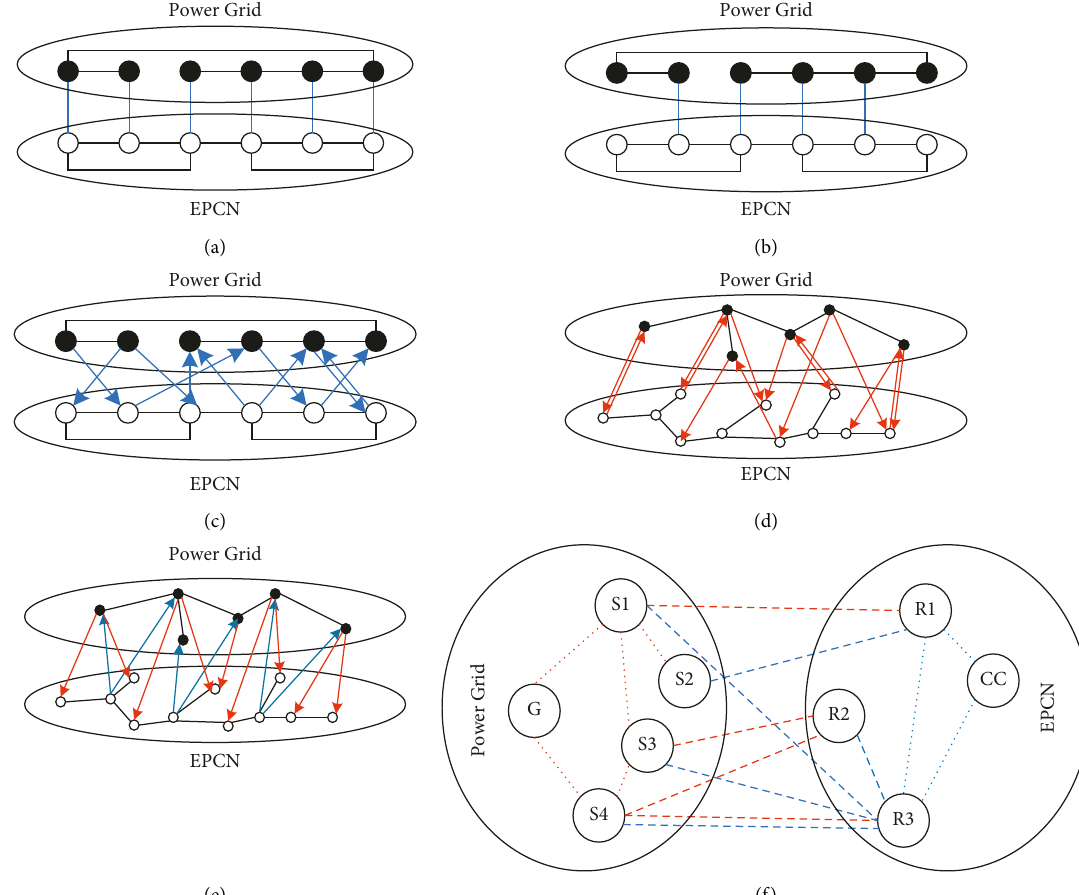
Figure 1: Origin models for interdependent networks. (a) “One-to-one” interdependent network. (b) “Partially interdependent” network. (c) Multidependent interdependent network. (d) “One-to-many” interdependent network. (e) “Many-to-many” interdependent network. (f) Cyber-physical power interdependent network considering node